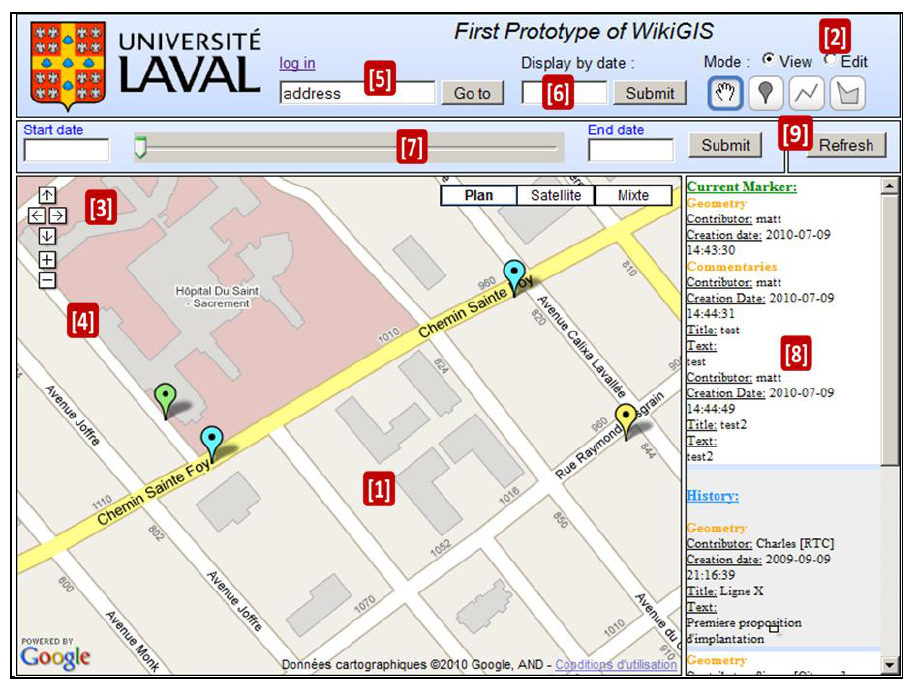
Figure 1. WikiGIS